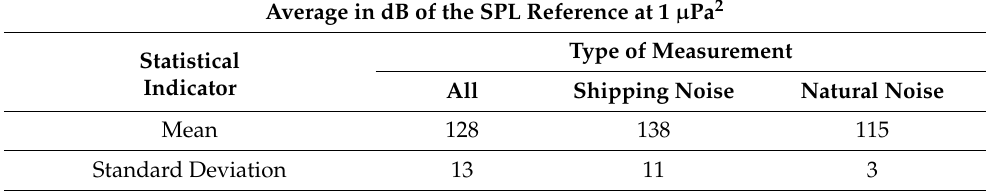
Table 3. Average and standard deviation of the SPL estimated for overall bandwidth for all shipping and natural noise